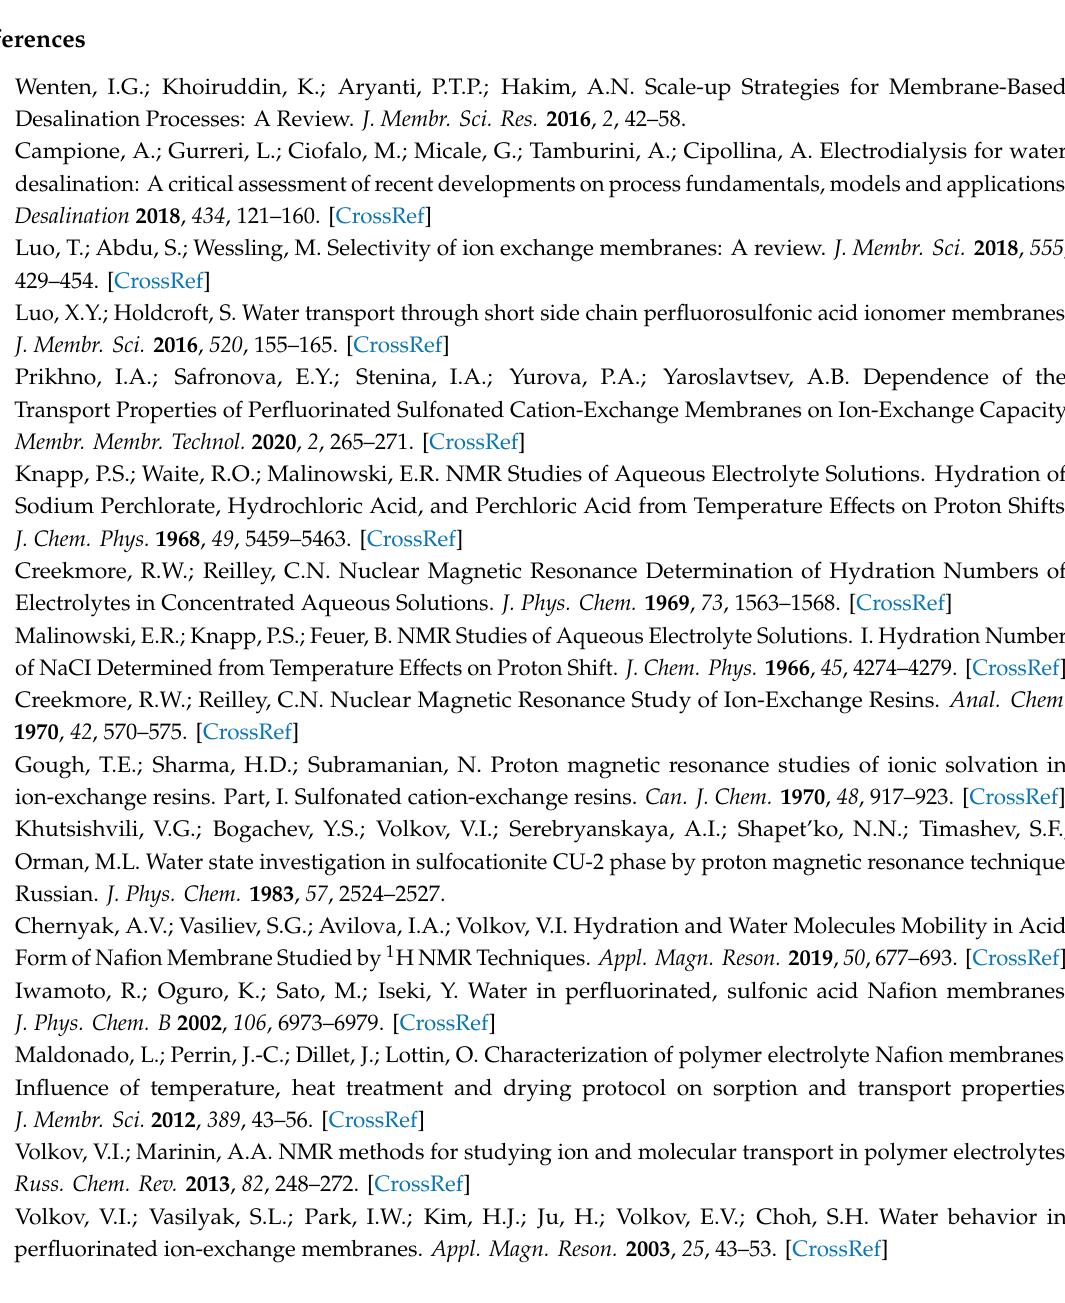
RH; Figure S2: 1 H NMR spectrum in H + ionic form of MSC membrane at RH = 95% and T = 293K; Figure S3: NMR spectra of 7 Li (a), 23 Na (b) and 133 Cs (c) nuclei in appropriate ionic form of MSC membrane at RH =